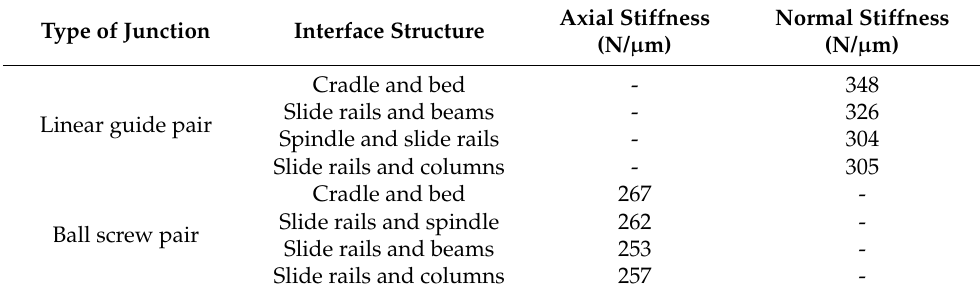
Figure 13. Machine tool processing space and grid division; ( a ) Machine tool processing space; ( b ) Machine tool grid division. Table 5. Machine tool joint stiffness.